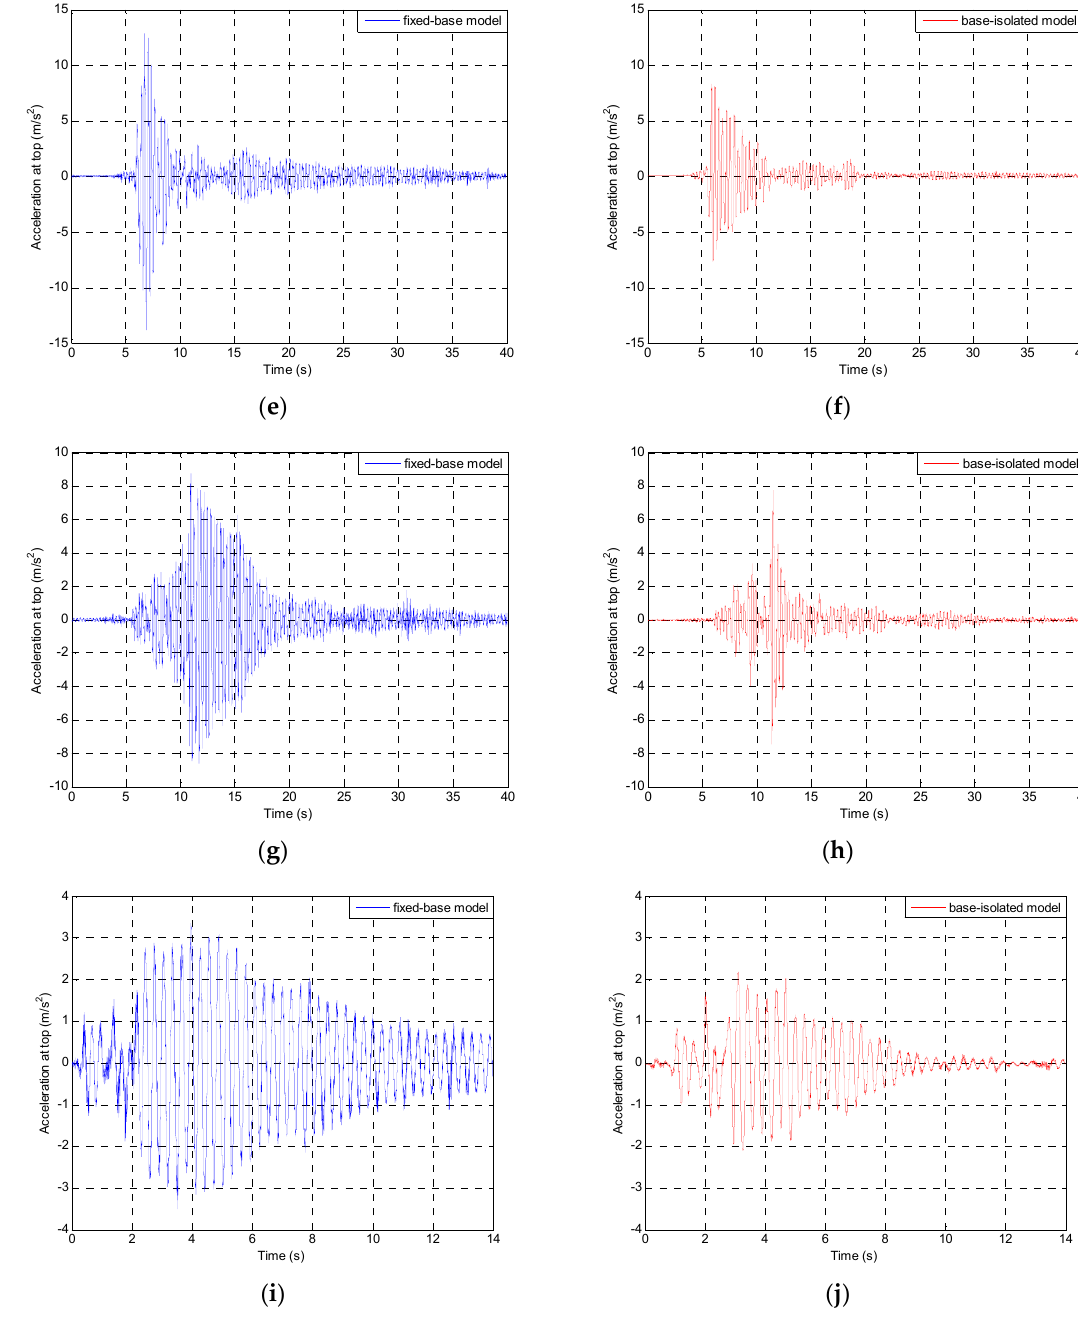
Figure 11. Time-acceleration history plots for the fixed-base (blue) and base-isolated (red) single-storey model during different earthquakes: the 1940 El Centro earthquake ( a , b ), the 1971 San Fernando earthquake ( c , d ), the 1989 Loma Prieta earthquake ( e , f ), the 1994 Northridge earthquake ( g , h ), and the 2002 Polkowice mining tremor ( i , j ).